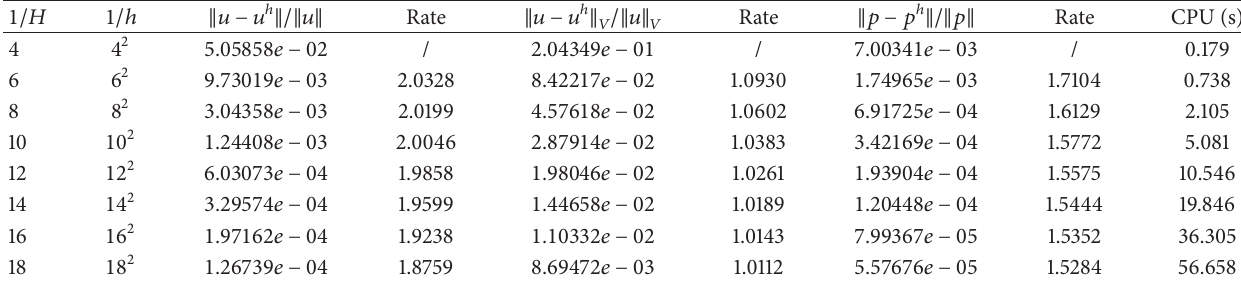
Table 2: Convergence of two-level Oseen iteration